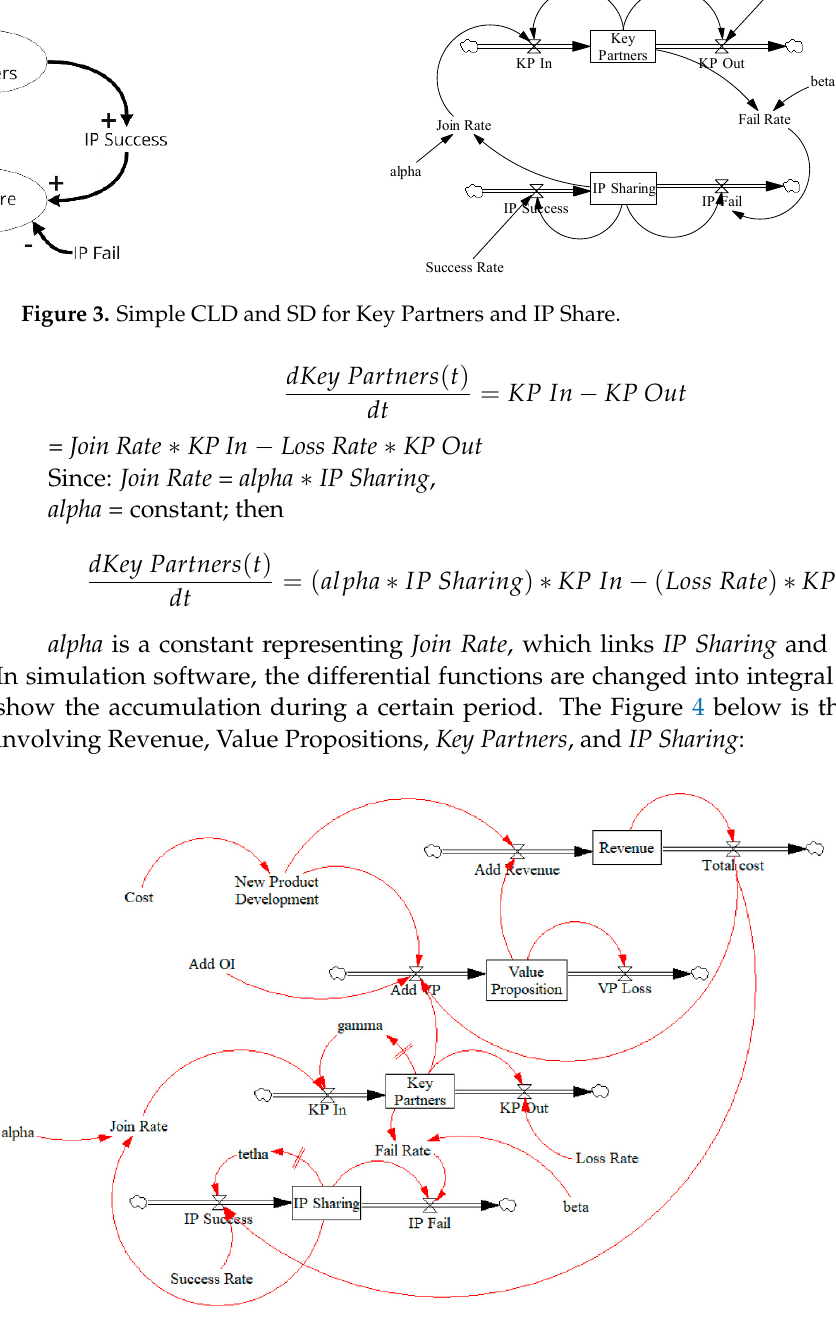
Figure 4. System dynamics for business model innovation.